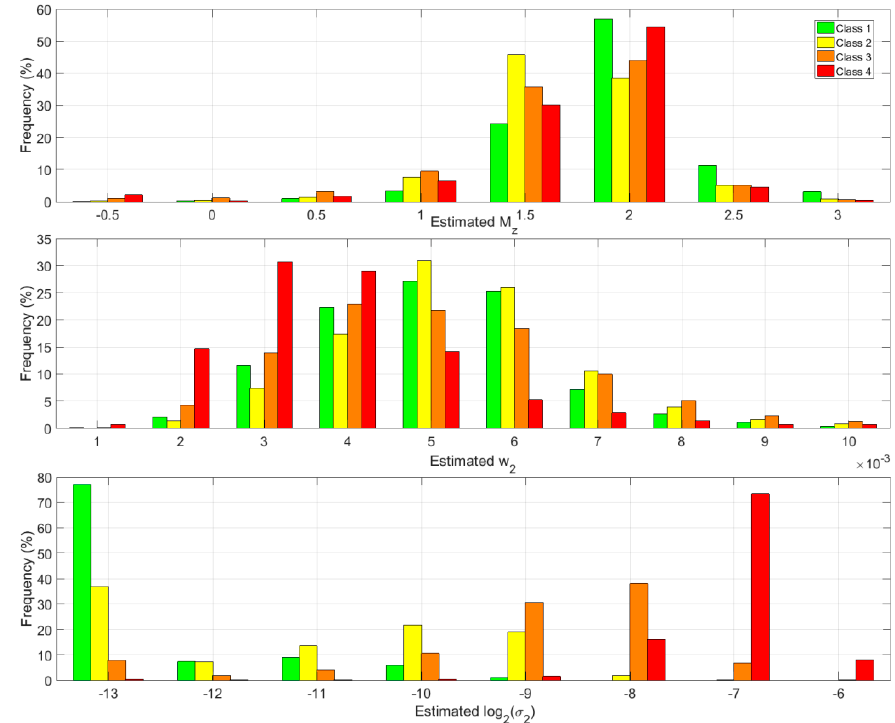
Figure 7. Histogram of inverted mean grain size M z ( top ), spectral strength w 2 ( middle ), and volume scattering parameter σ 2 in log scale ( bottom ) categorized versus Bayesian acoustic